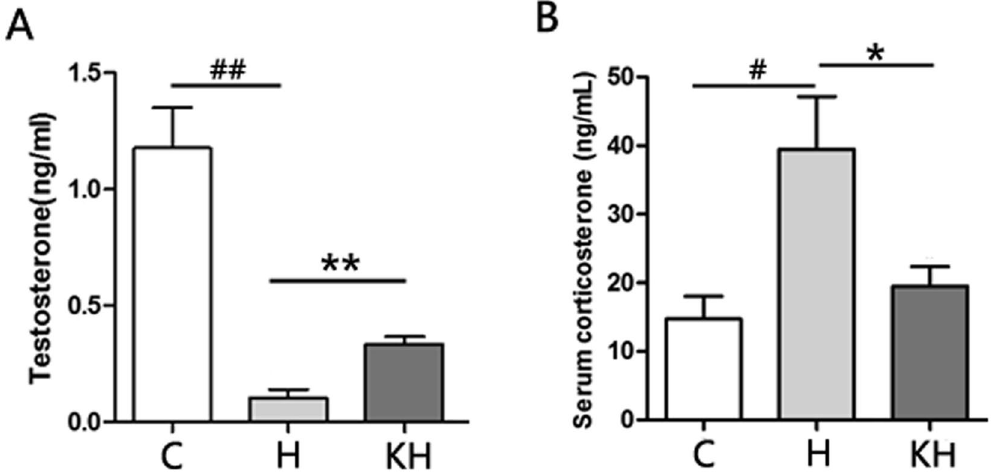
Figure 4. ( A ) Effects of heat challenge and kisspeptin treatment on testosterone level in rat serum. ( B ) Effects of heat challenge and kisspeptin treatment on corticosterone level in rat serum. Date are expressed as mean ± SD (n = 7). ## Indicates p < 0.01 compared to the C group; ** Indicates p < 0.01 compared to the H group. C: control group; H: Heat stress group; KH group: Kisspeptin + Heat stress